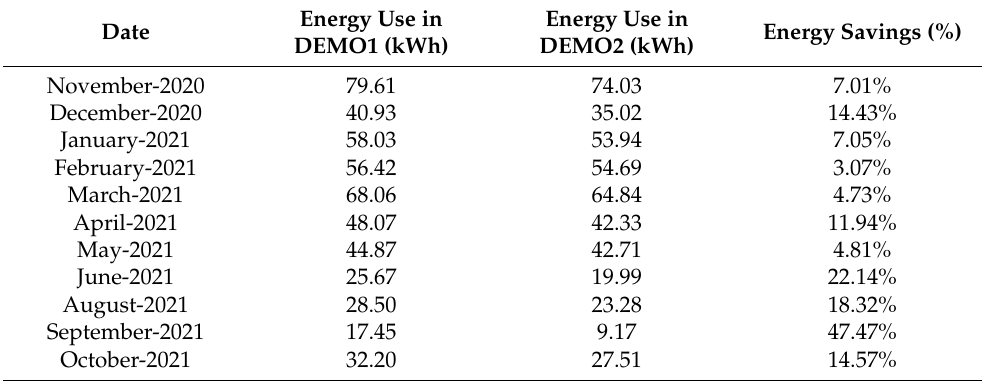
Table 4. Energy use in each test cell during the testing period with CrodaTherm-based